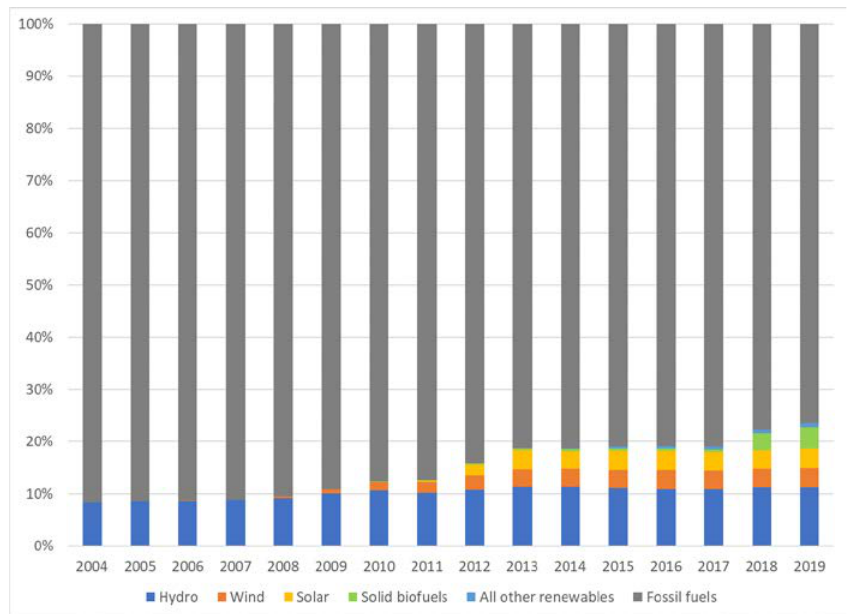
Figure 1. Electricity mix of Germany. Based on Eurostat shares data.